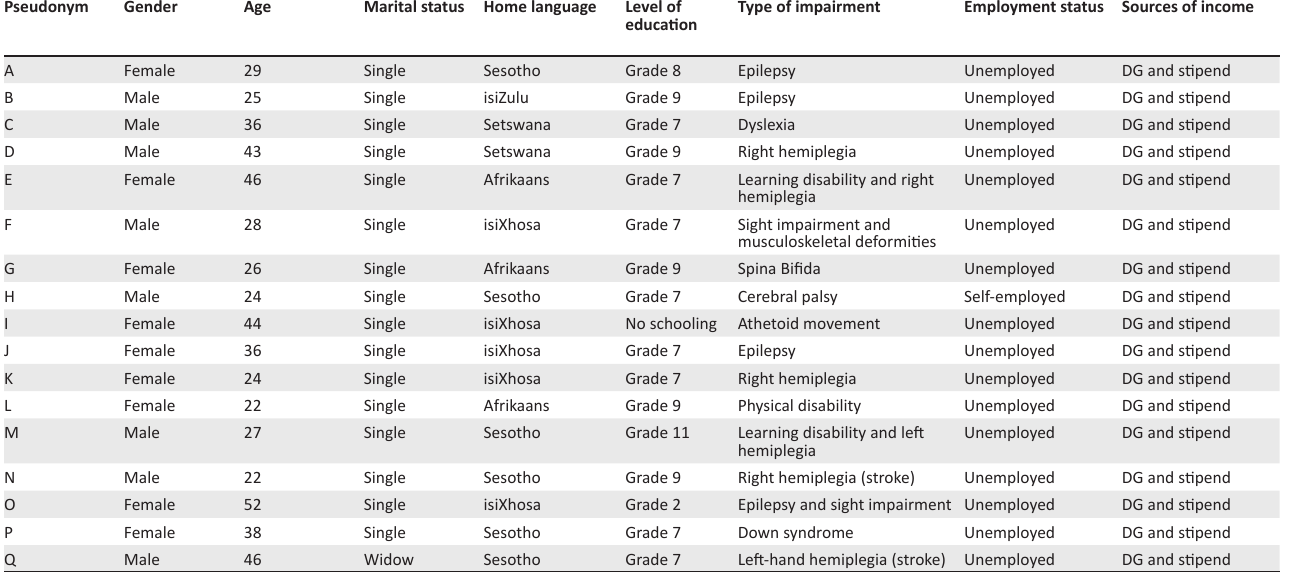
TABLE 1: Participants’ socio-economic